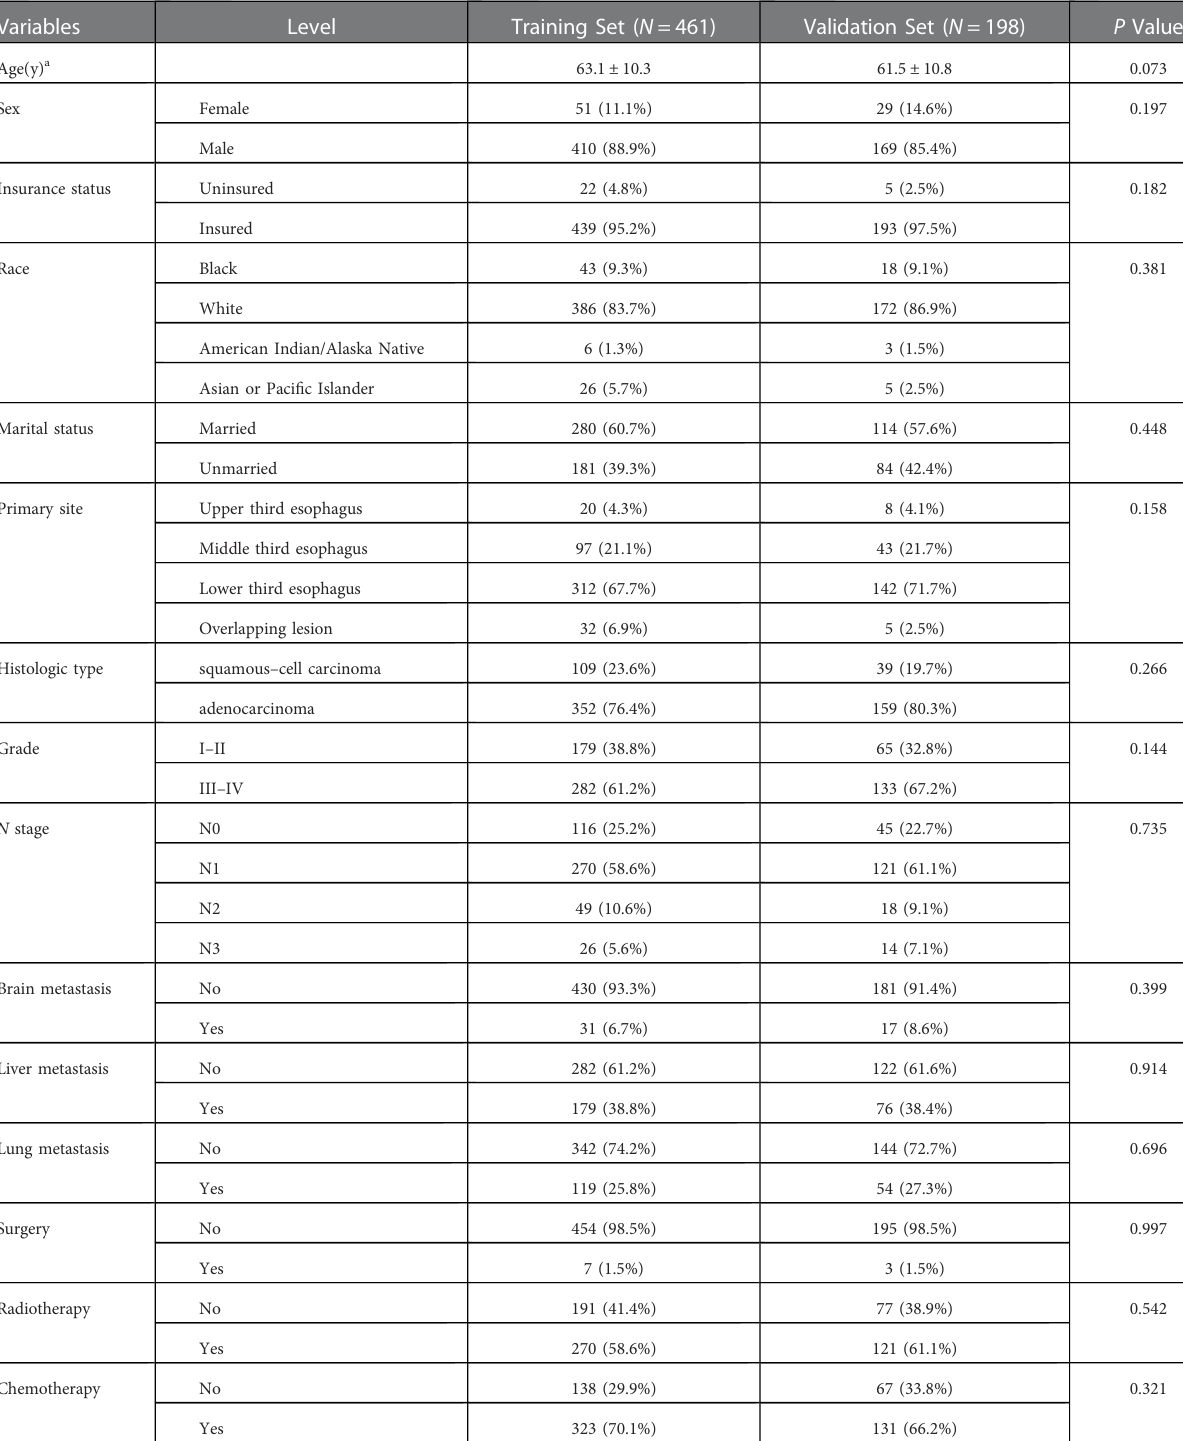
TABLE 4 Comparison of characteristics between training and validation groups in esophageal cancer patients with bone metastasis.